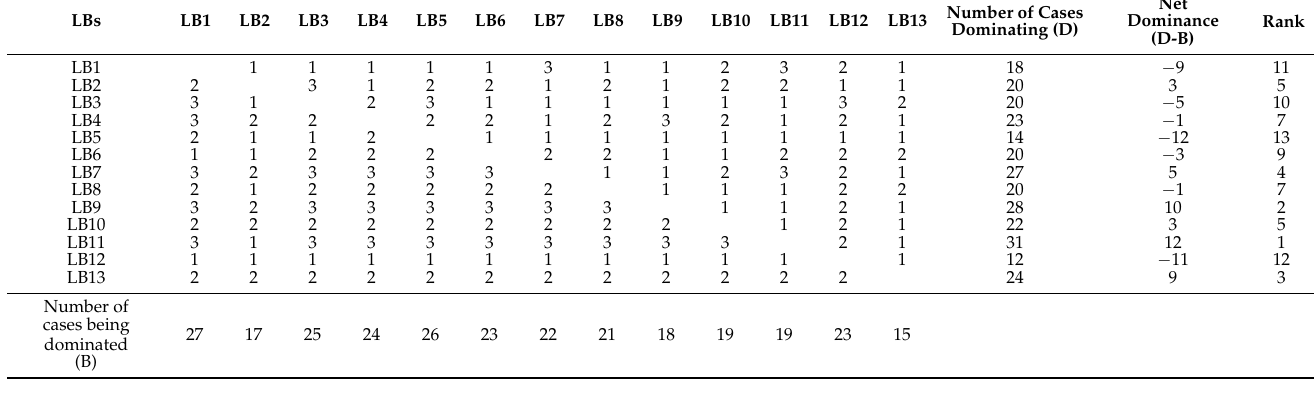
Table 11. Dominance matrix (DM).